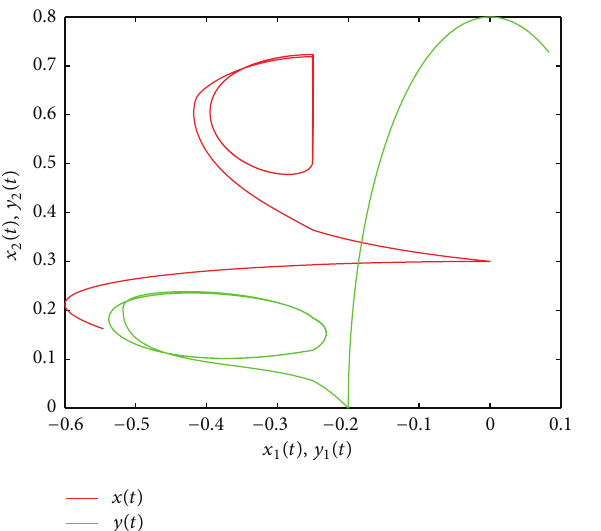
Figure 5: Trajectories of control parameters 𝛼 1 (𝑡) and 𝛼 2 (𝑡) .